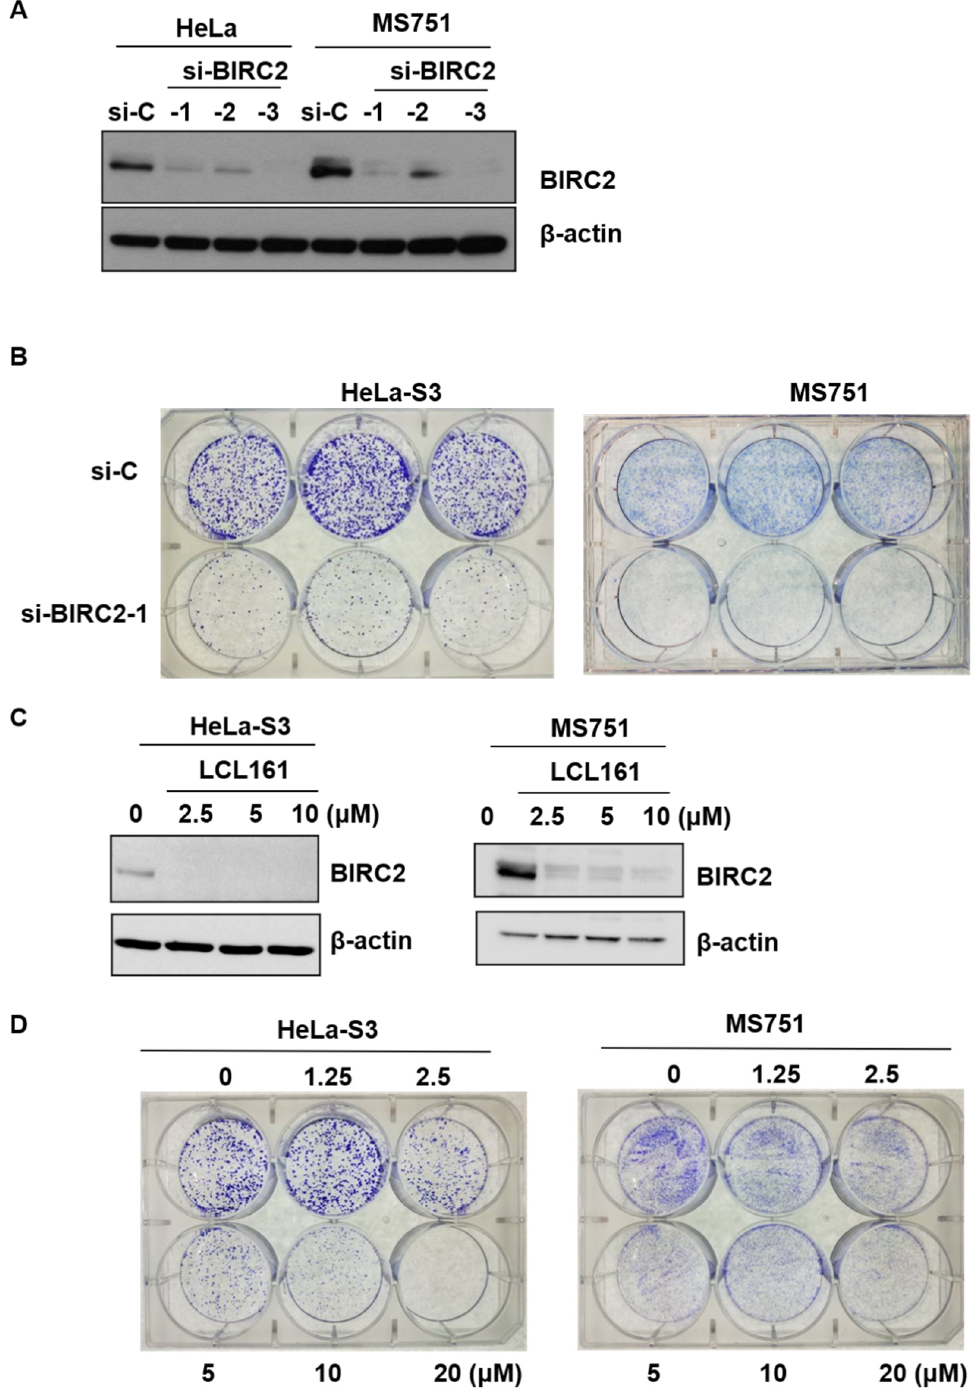
Figure 4. Effect of LCL161 on clonogenicity. ( A ) HeLa-S3 or MS751 cells were transiently transfected with nontargeting siRNA (si-control, si-C), BIRC2 siRNA (si-BIRC2-1, -2, -3) for 72 h. Cell lysates were subjected to Western blotting using antibodies raised against BIRC2 and β -actin. ( B ) HeLa-S3 or MS751 cells were treated with si-C and si-BIRC2-1 for 7–14 days. Colony formation was analyzed through the clonogenic assay. ( C ) HeLa-S3 or MS751 cells were treated with BIRC2 inhibitor LCL161 for 24 h and cell lysates were subjected to Western blotting using antibodies raised against BIRC2 and β -actin. ( D ) HeLa-S3 or MS751 cells were treated with vehicle or varying doses of LCL161 (1.25, 2.5, 5, 10, and 20 μ M) for 7–14 days. Colony formation was analyzed through the clonogenic assay.